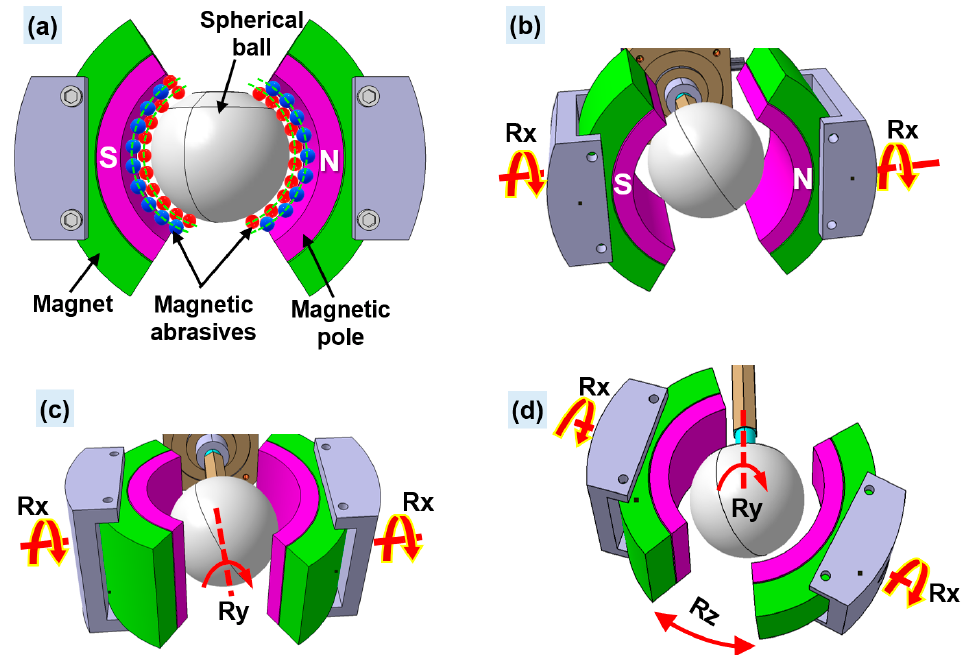
Figure 14. Working principle of a cylindrical MAF process using a multi-axis/multi-faceted finishing technique for the surface finishing of a spherical ceramic ball ( a ) spherical ball inside the magnetic abrasive brush ( b ) magnetic pole rotating on X-direction ( c ) spherical ball rotating on Y-direction and ( d ) magnetic pole rotating on Z-direction.